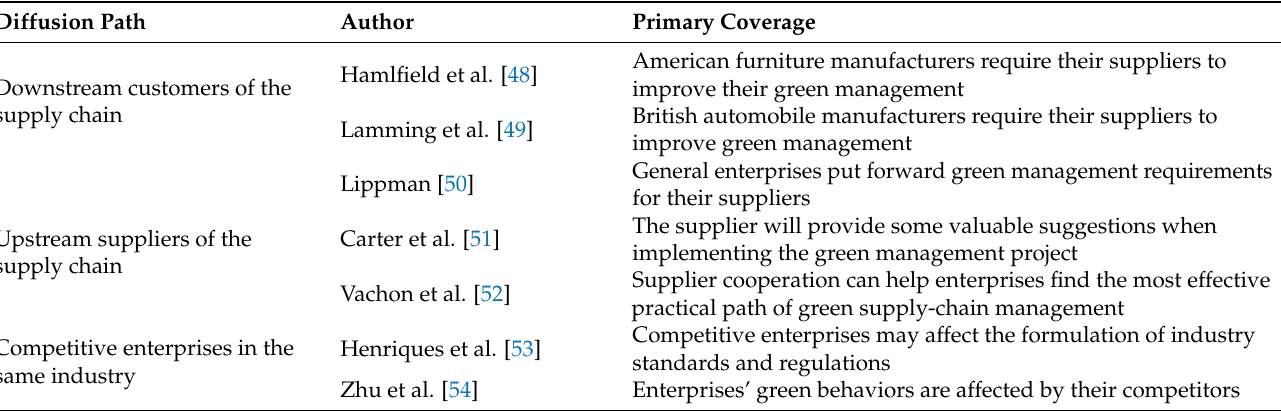
Table 2. Green supply-chain diffusion